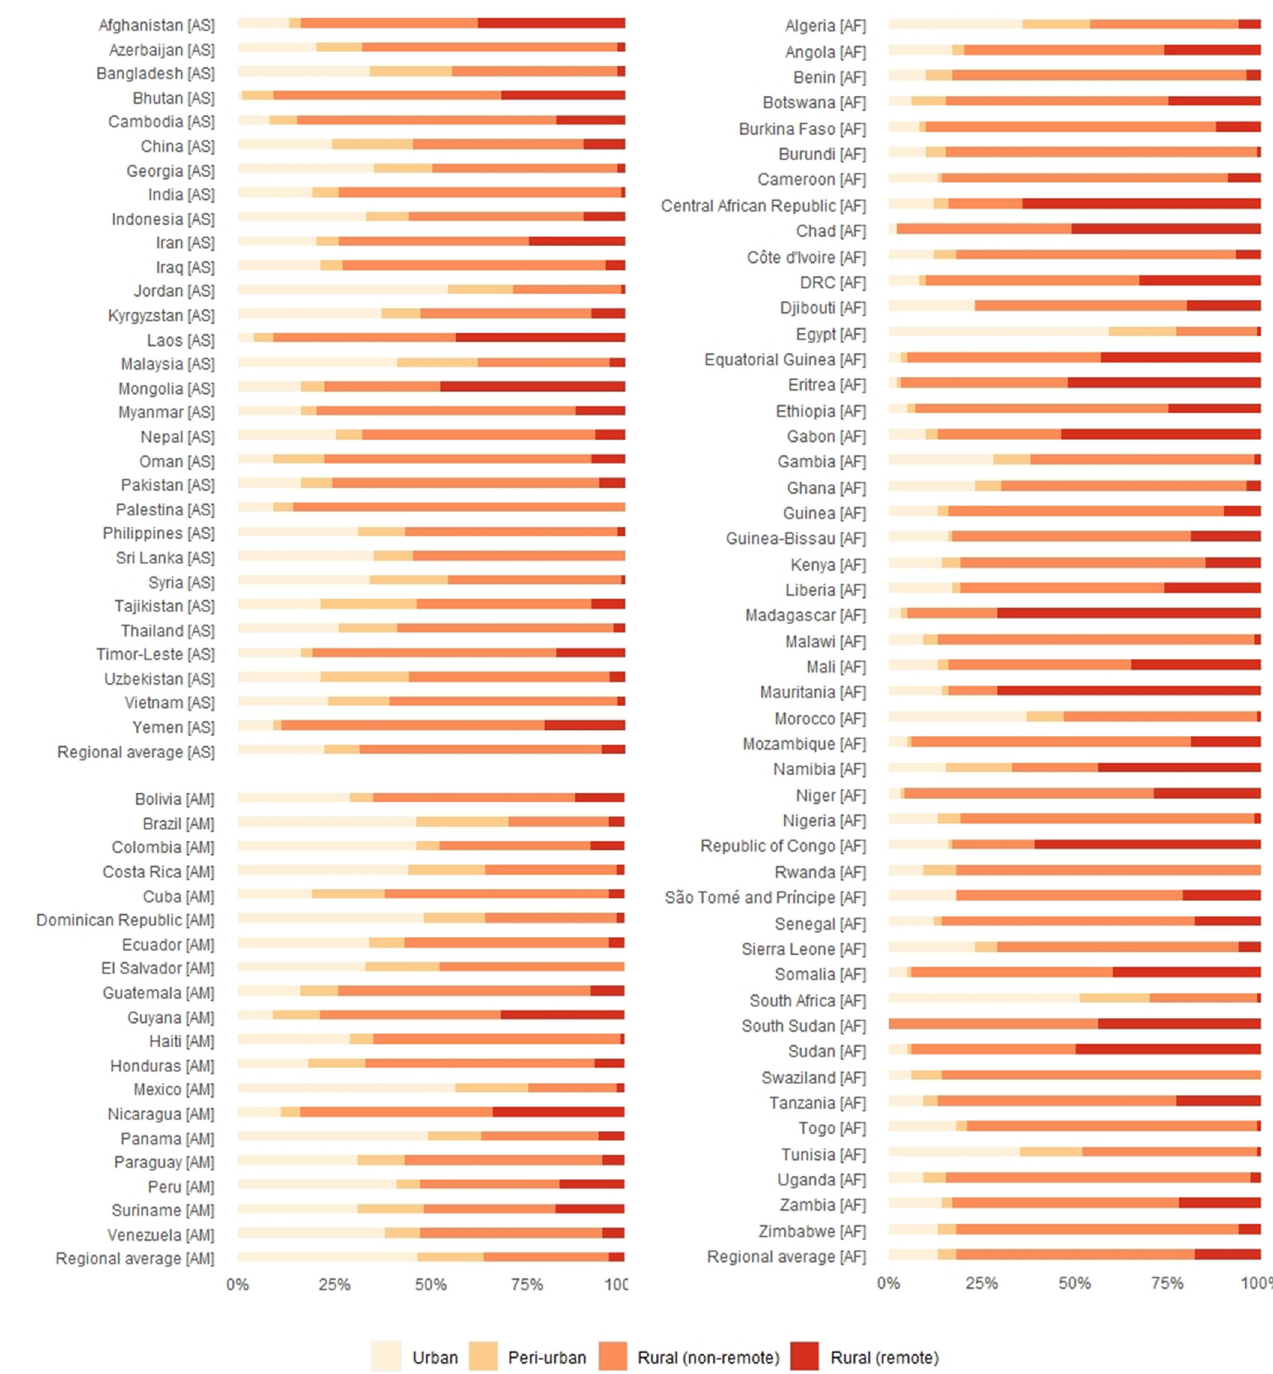
Fig 4. Plot showing the estimated breakdown of children under 1 year of age not receiving DTP1 in 2019 by urban/peri-urban/rural (non-remote)/rural (remote) characteristics, for all countries in the study area in Latin America (AM), Africa (AF), and Asia (AS), and also regional averages.